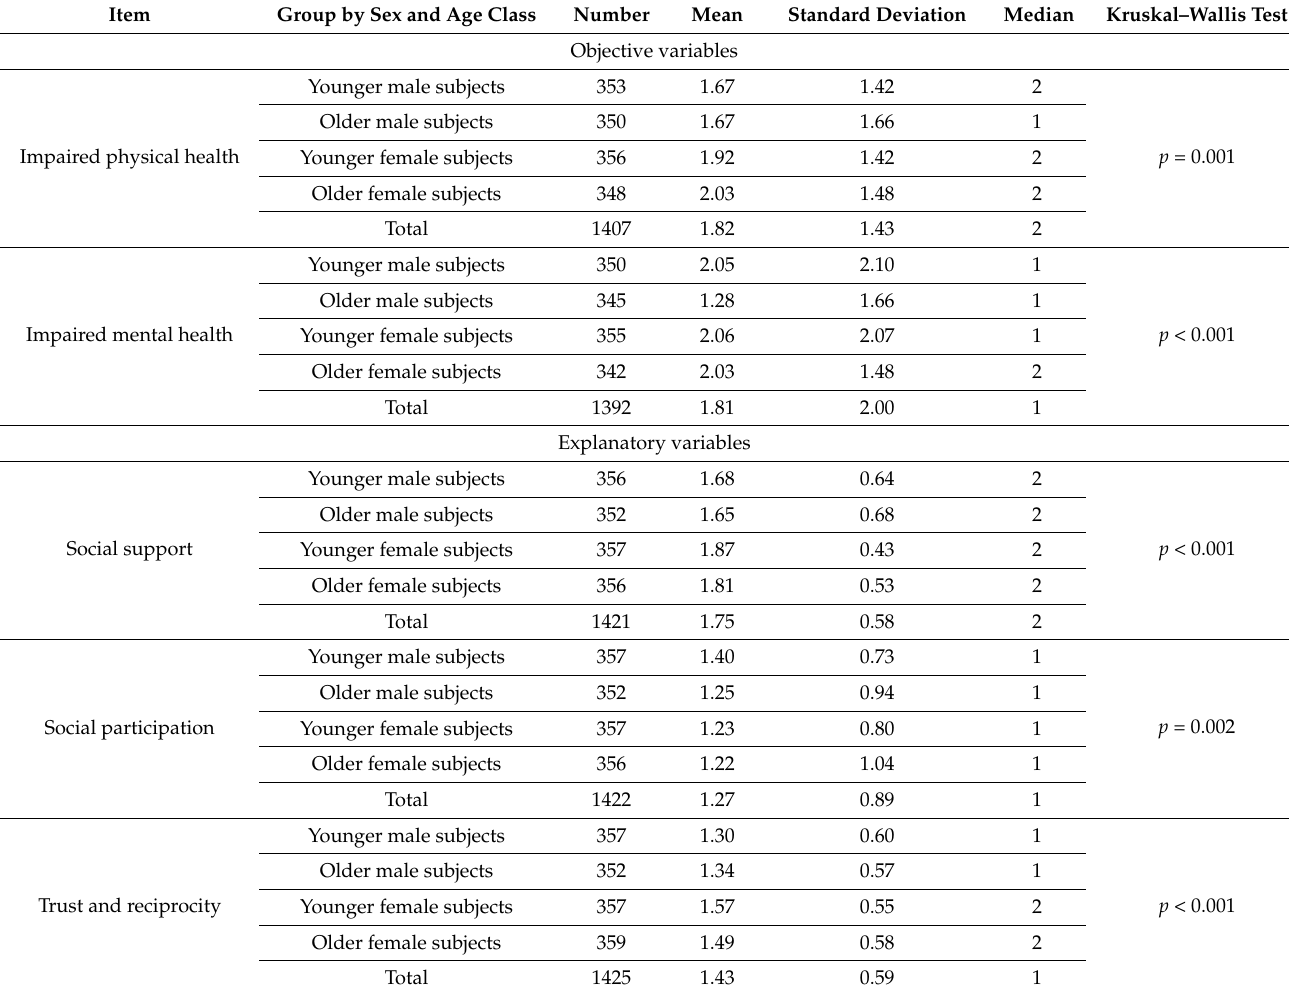
Table 1. Distribution of objective and explanatory variables according to the four groups by sex and age classes $